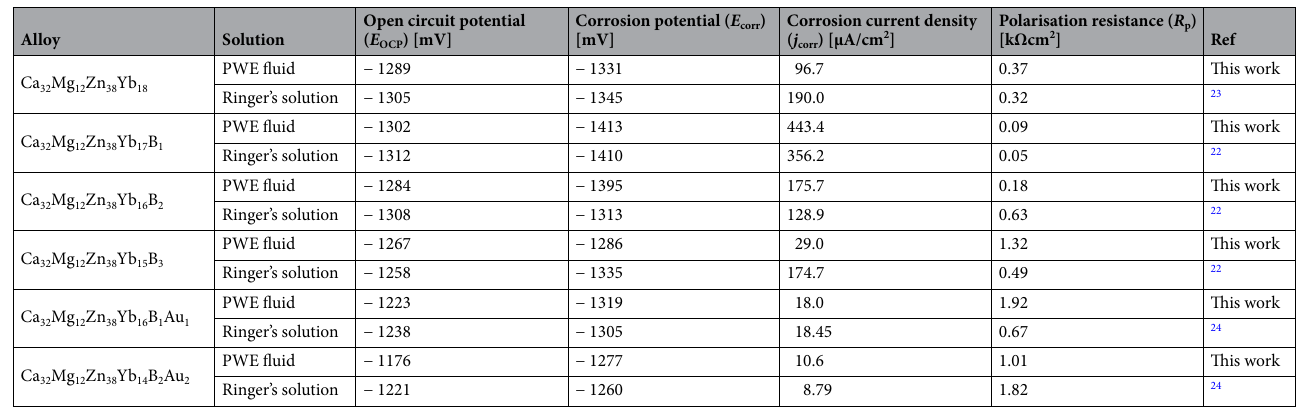
Table 2. Comparison of electrochemical properties for Ca 32 Mg 12 Zn 38 Yb 18-x B x (x = 0, 1, 2, 3 at.%) and